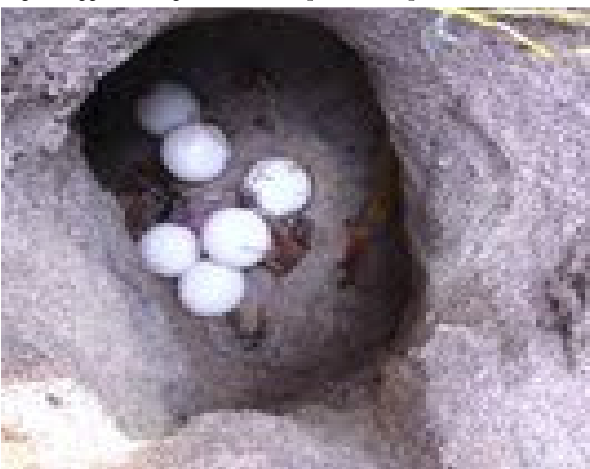
Fig. 3. Eggs of the green turtle kept on the plastic mat